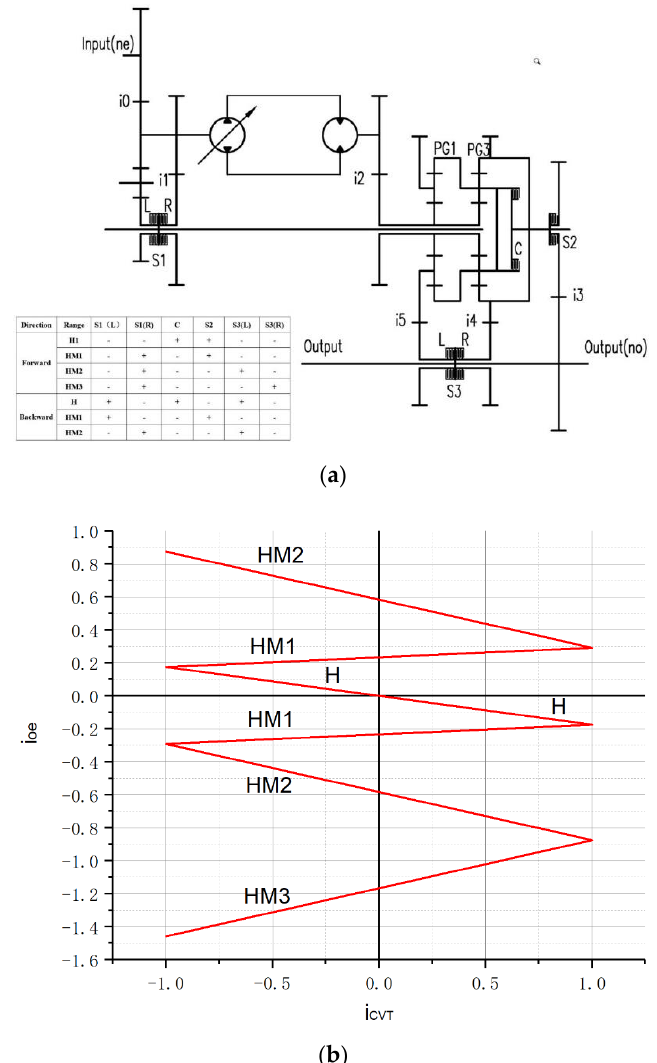
Figure 18. The structural scheme and transmission ratio, 𝑖 𝑜𝑒 , of the multi-range HMCVT: ( a ) The structural scheme of multi-range HMCVT; ( b ) The curve of transmission ratio 𝑖 𝑜𝑒 .